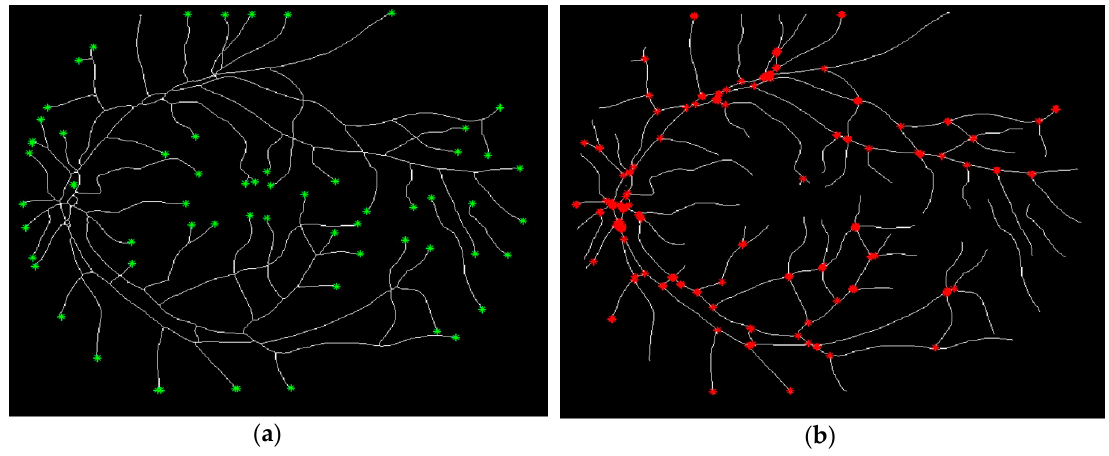
( b ) Figure 7. Binarization and skeletonization image: ( a ) Binary image; ( b ) Skeletonization image.